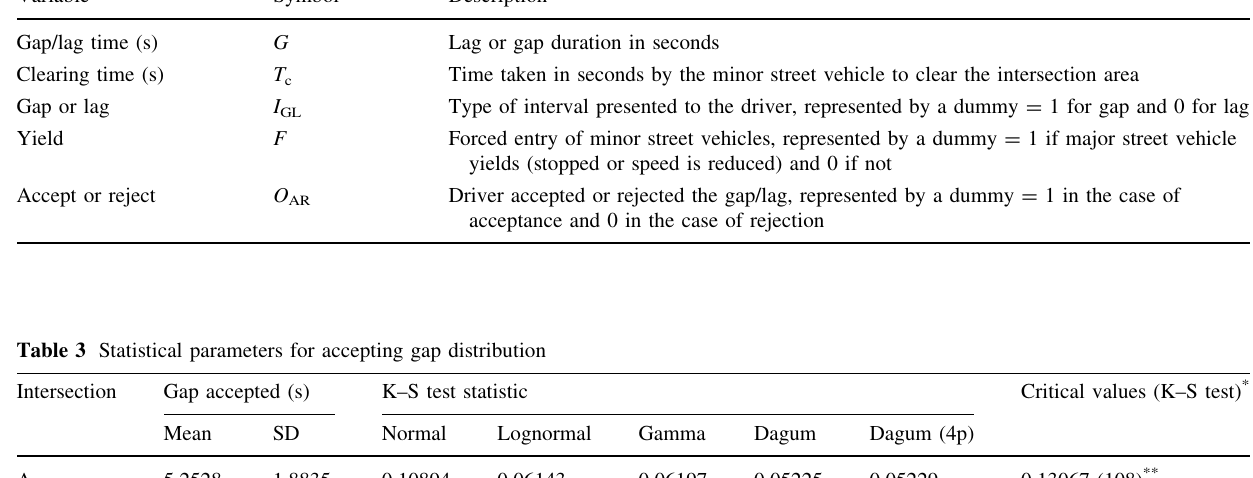
Table 2 List of variables extracted from videotape Variable Symbol